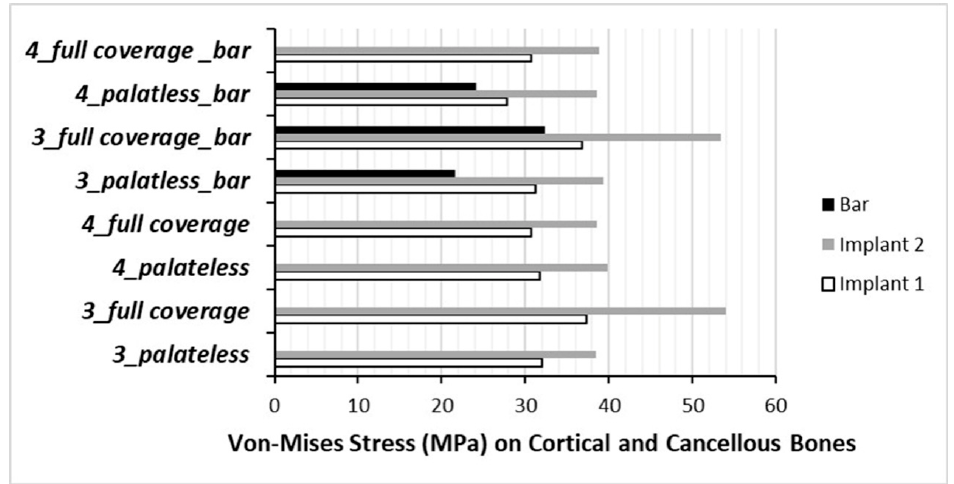
Figure 10. Von Mises stress (MPA) in cortical and cancellous bone for palateless three- and four-implant models with and without connecting bar.